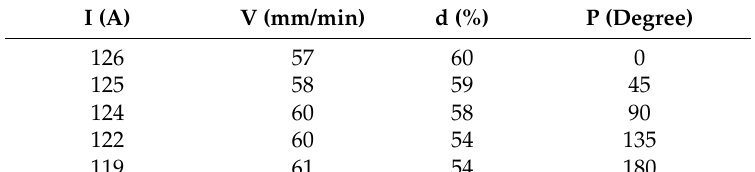
Table 9. Optimal parameters.